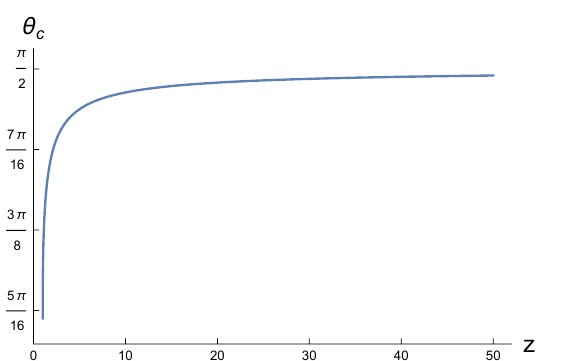
Figure 2: The angle θ for the open string amplitude in the 12 ↔ 34 kinematics as c a function of z .